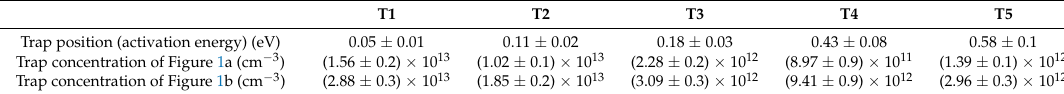
Table 1. Summary of the main trap levels of two types of